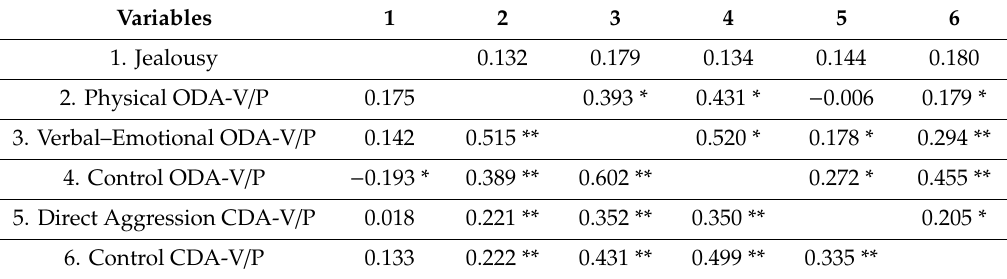
Table 3. Pearson’s correlations among the variables of the study.